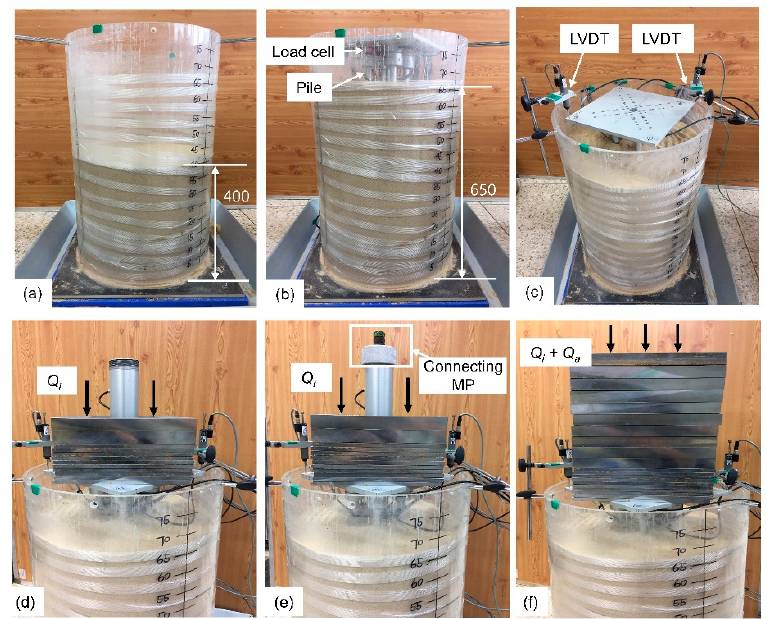
Figure 4. Experimental set-up for underpinned foundation loading test. ( a ) Preparation of loose sand layer; ( b ) installation of pile foundation and preparation of dense sand layer; ( c ) installation of linear variable differential transformers (LVDTS); ( d ) initial loading Q i to existing foundation; ( e ) connection of micropile to existing foundation; and ( f ) additional loading Q a to underpinned foundation.